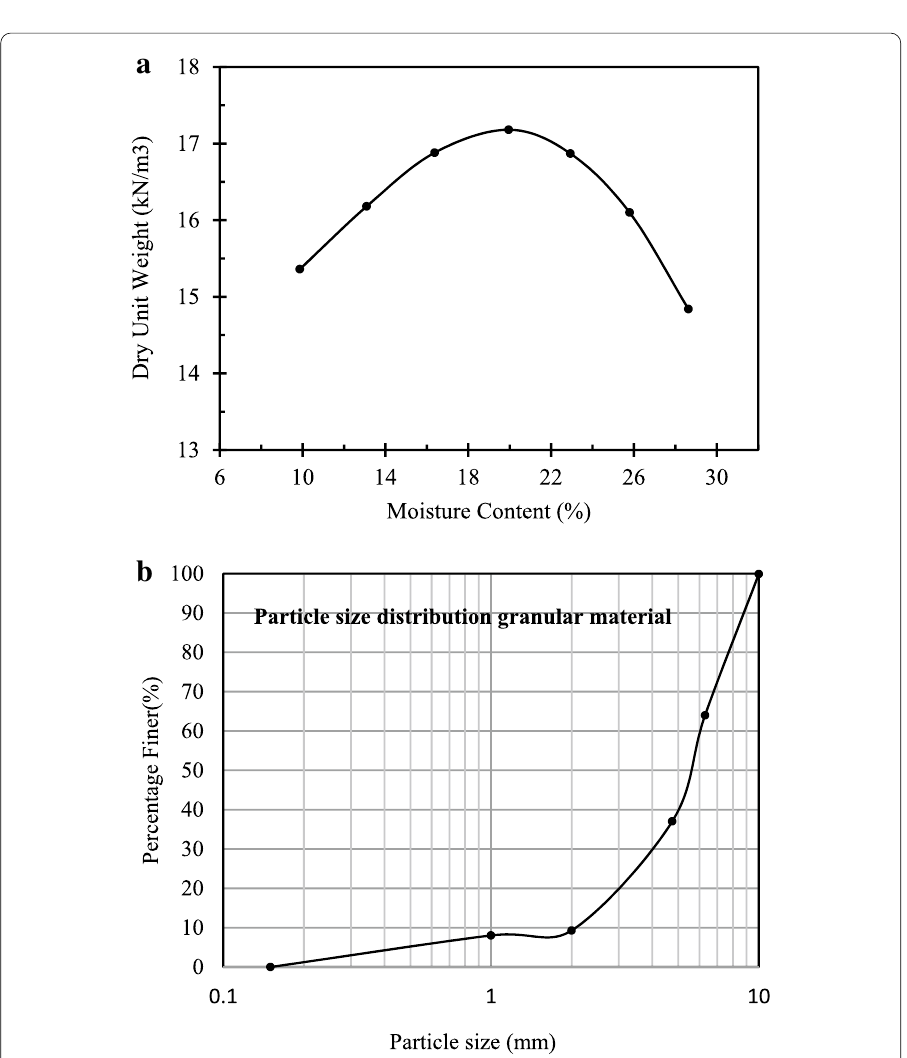
Fig. 3 a Proctor compaction curve for clayey soil. b Particle size distribution curve for GPA